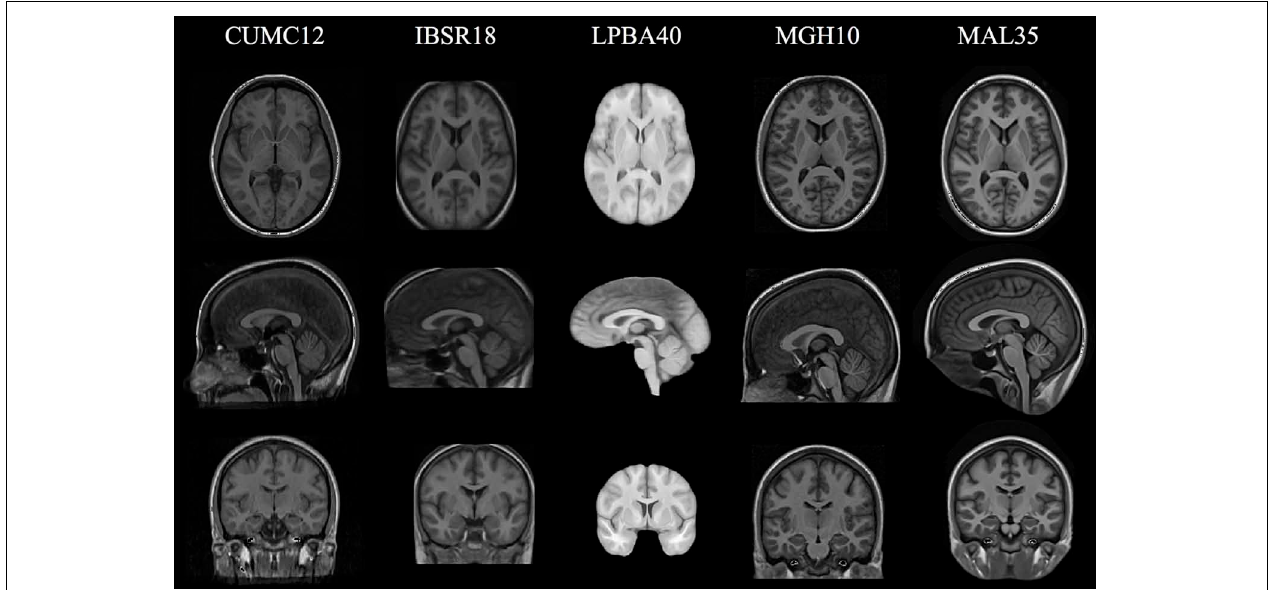
FIGURE 2 | Canonical views for each of the five cohort-specific templates generated using the ANTs tools as described in Avants et al. (2010). The pseudo-geodesic transform between subjects is created from the composition of transforms to/from the relevant